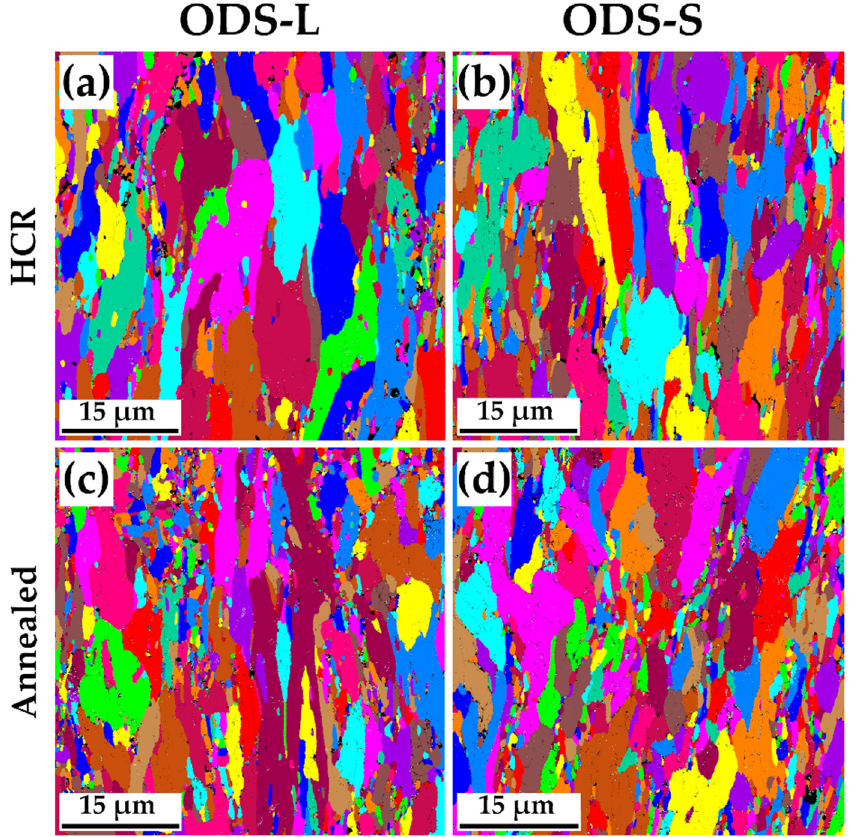
Figure 6. UGC maps of the ODS steels after HCR and after annealing at 1273 K: ( a ) ODS-L steel after HCR, ( b ) ODS-S steel after HCR, ( c ) ODS-L steel after annealing, and ( d ) ODS-S steel after annealing. The maps were taken along the TS